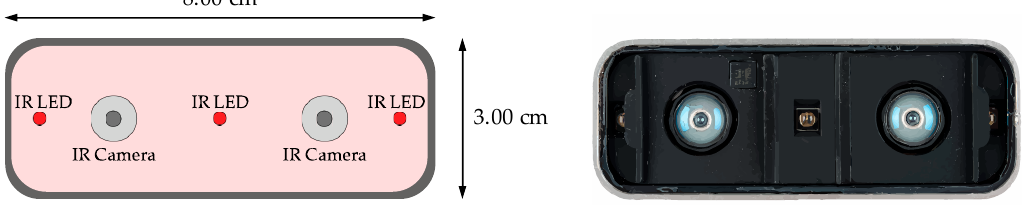
ff erent components of the Leap Motion hardware system. Figure 9. Different components of the Leap Motion hardware system. Figure 9. Di